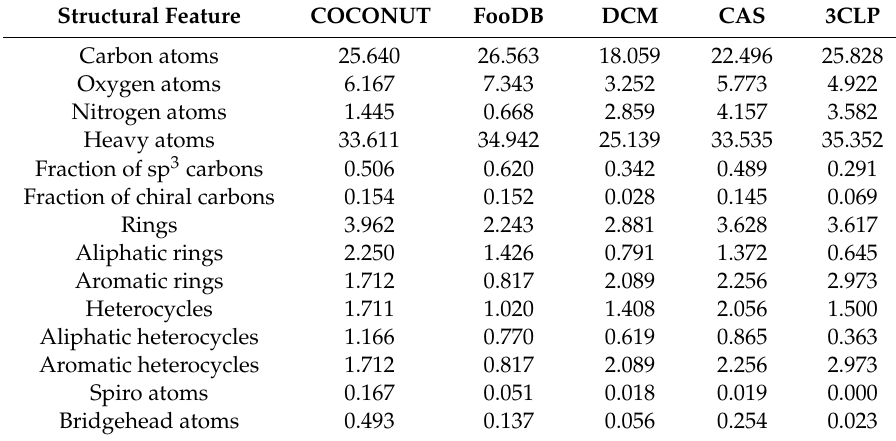
Table 2. Summary of the structural composition of compounds from COCONUT, FooDB, and reference datasets a .